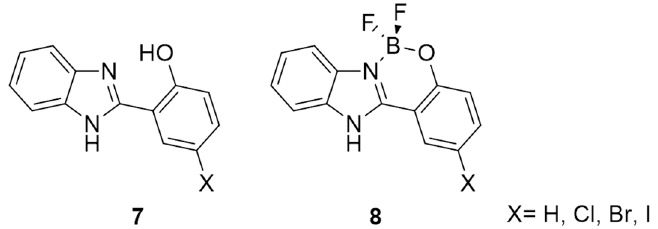
Figure 2. Halogenated boron complexes 8 based on 2-(1H-benzo[d]imidazol-2-yl)phenol 7 studied in this work.